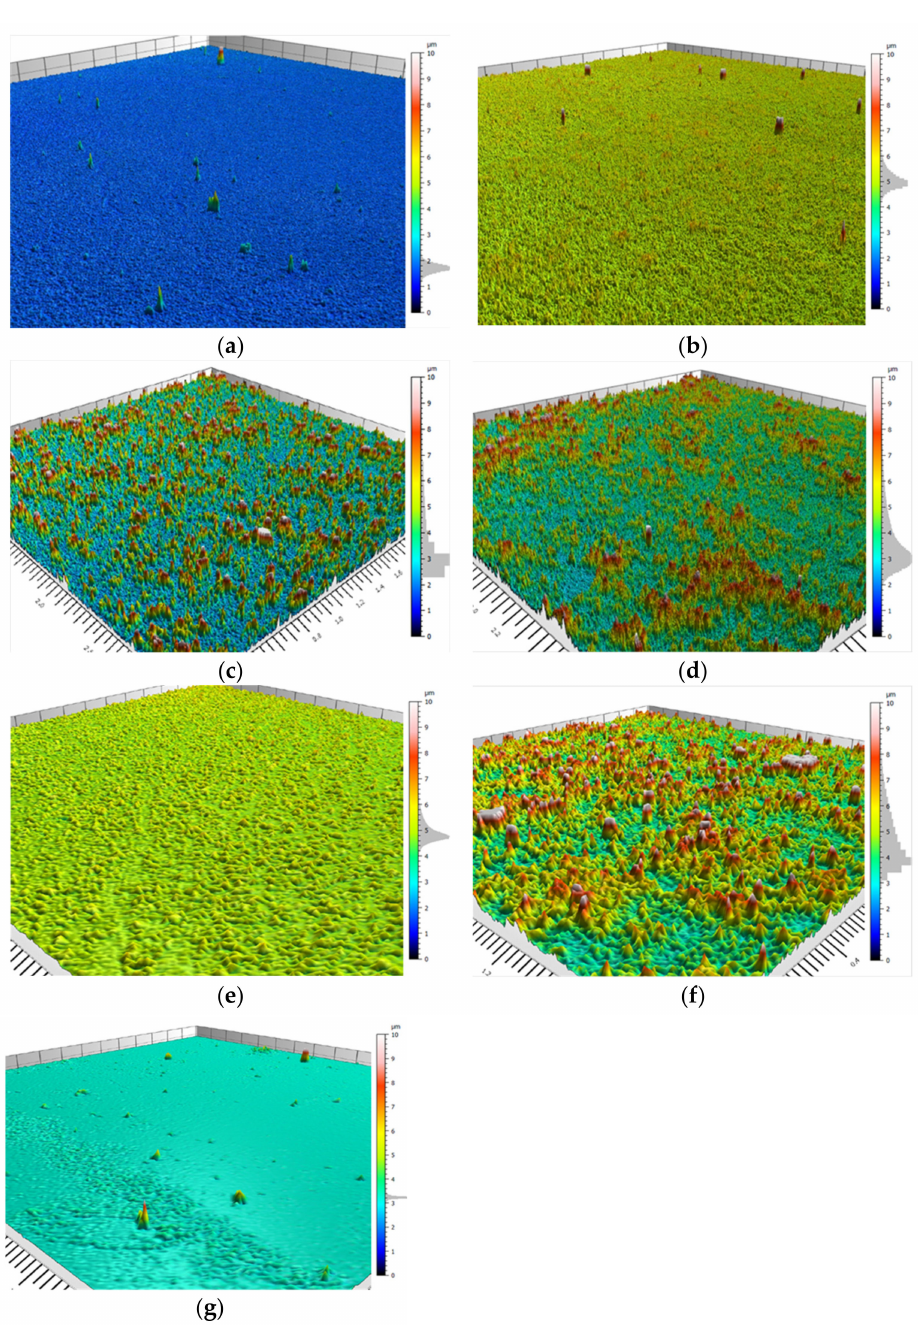
Figure 7. Confocal microscopy of ( a ) TEOS:DTMS at a ratio of 7:3, ( b ) TEOS:DTMS at a ratio of 6:4, ( c ) TEOS:DTMS at a ratio of 5:5, ( d ) TEOS:DTMS at a ratio of 4:6, ( e ) TEOS:DTMS at a ratio of 3:7, ( f ) TEOS:ODTMS at a ratio of 5:5, and ( g ) TEOS:PrTMS at a ratio of 5:5. Scale in µ